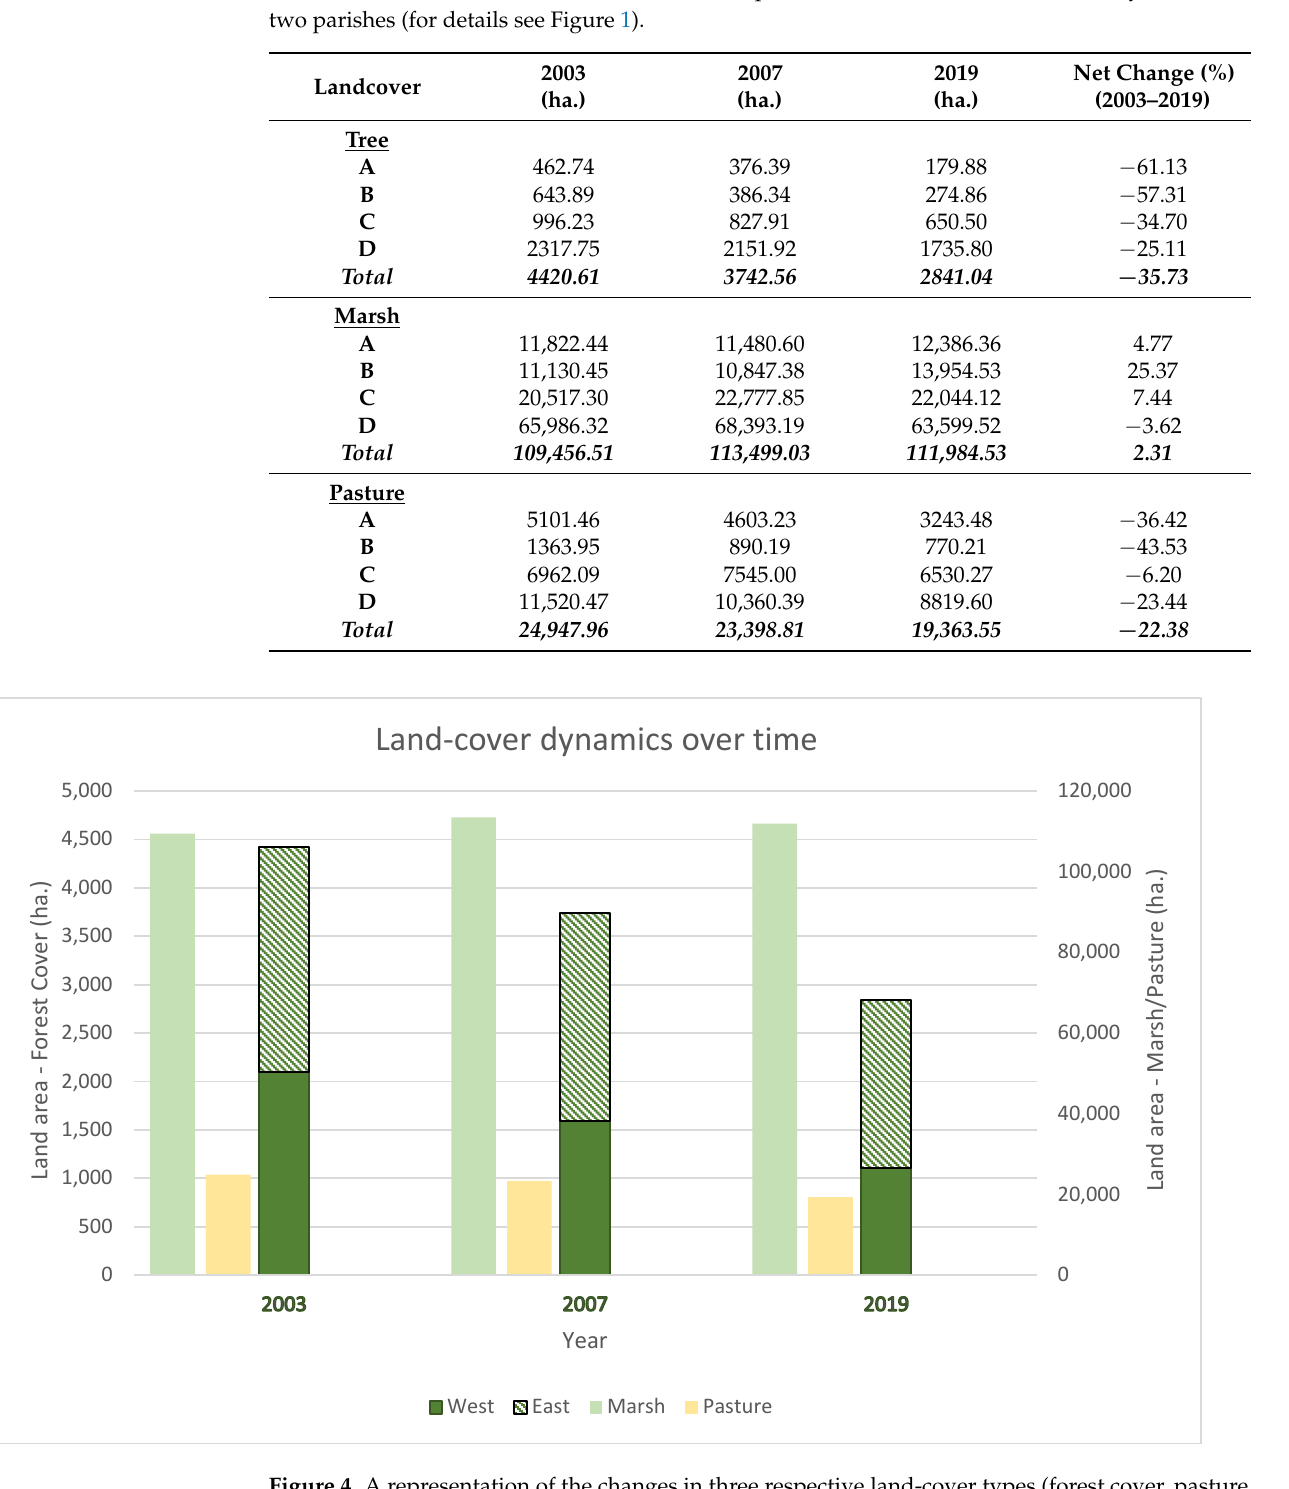
Figure 4. A representation of the changes in three respective land-cover types (forest cover, pasture, marsh) over the period 2003–2019. For forest cover the three western sections are represented as West and D is represented as East. Light green indicates marsh, yellow represents pasture, dark green and hatched green show forest